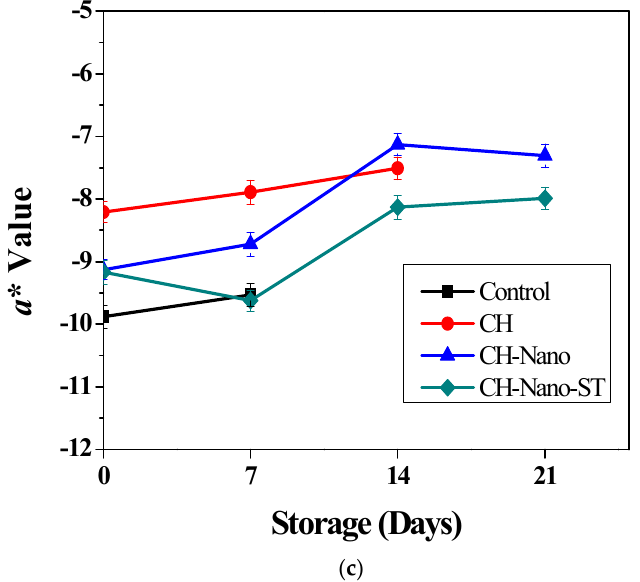
Figure 2. Effect of coating treatments of cucumber sampleson color index profile; ( a ) L* value, ( b ) a* value, and ( c ) b* value.